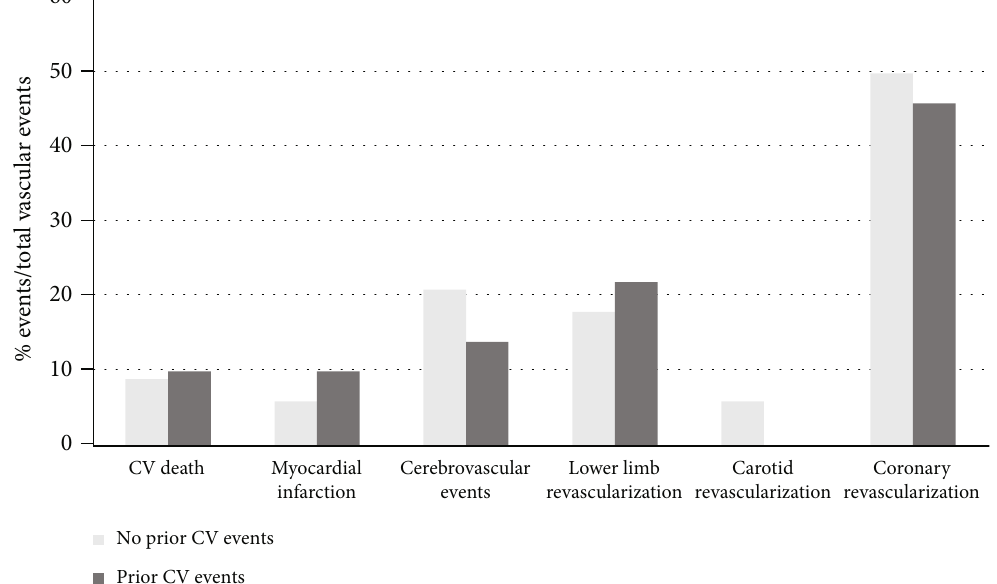
Figure 3: Distribution of new vascular events in patients with or without prior cardiovascular (CV) events.